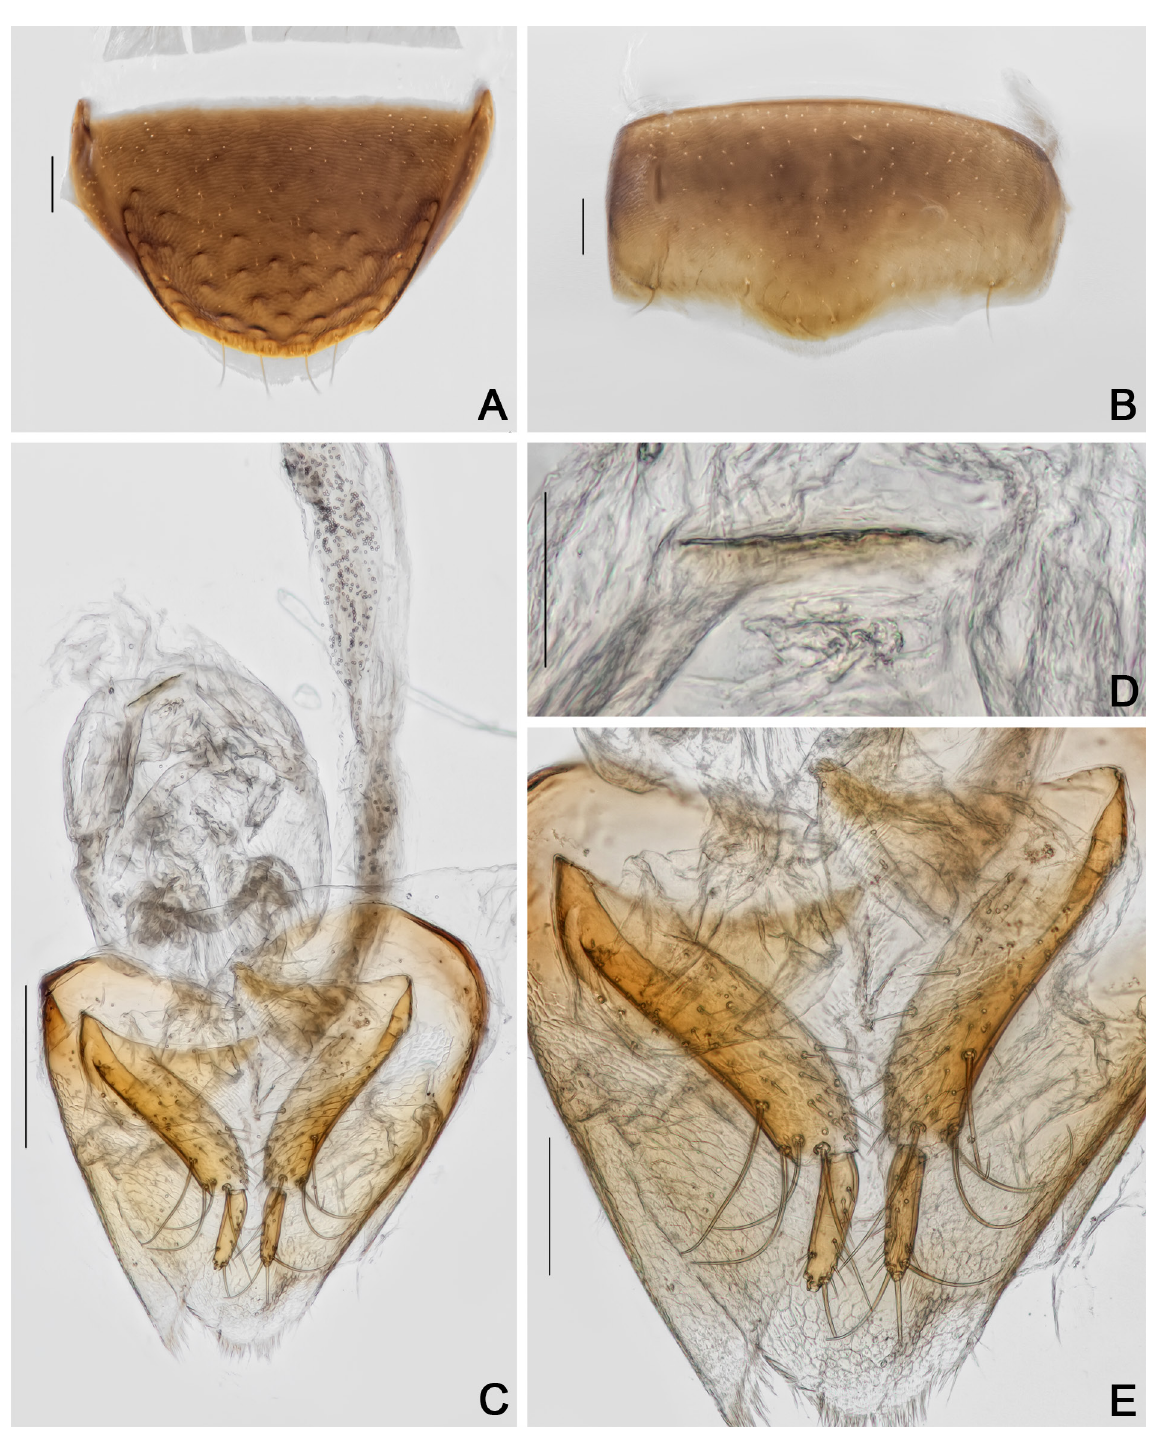
Fig. 54. Cyparium collare Pic, 1920, ♀ (CELC). A . Tergite VIII. B . Sternite VIII. C . Terminalia. D . Sclerite of vaginal plate. E . Ovipositor. Specimen collected at Mata do Paraíso, Viçosa (MG, Brazil). Scale bars: A–B, D–E = 0.1 mm; C = 0.2